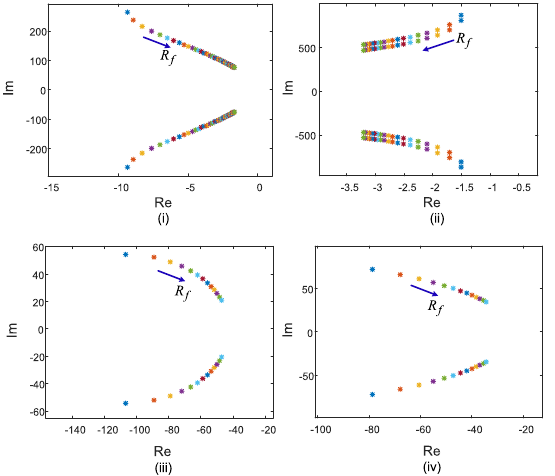
Fig. 10 Eigenvalue plot by changing the filter resistance (i) Droop (ii) VSM (iii) VOC (iv) VOC-PSO